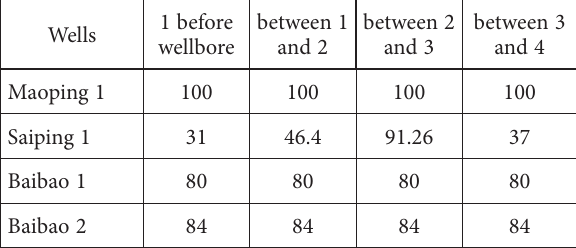
Table 3. Distribution of fractures